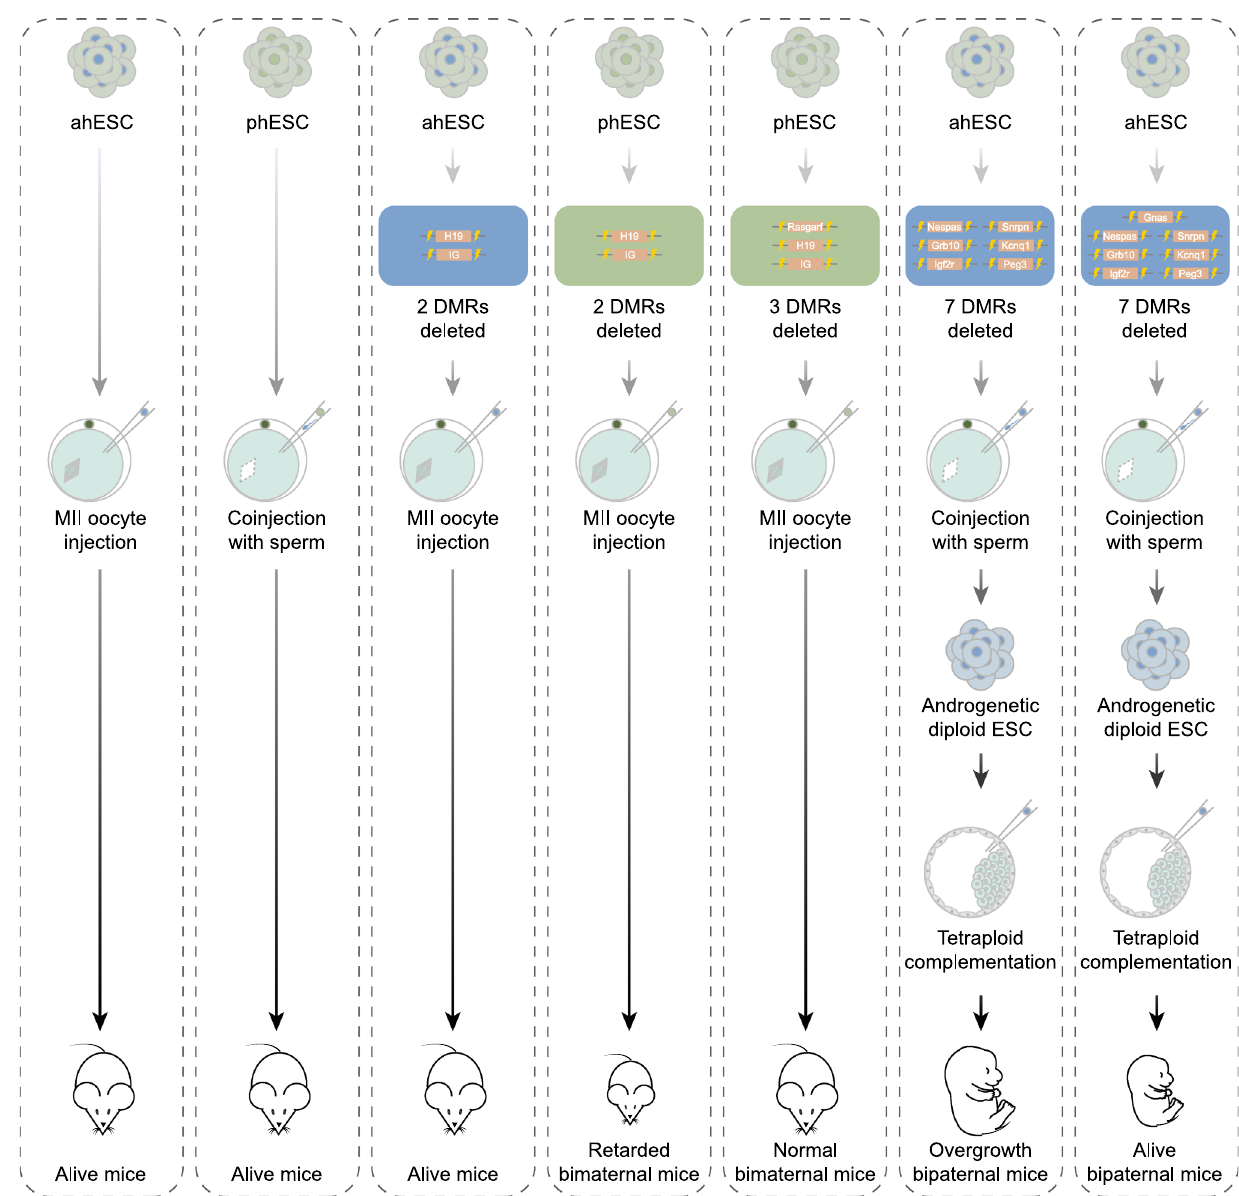
Figure 4. Haploid embryonic stem cells (haESCs) can be used to replace gametes for the generation of alive mice. Deletions of the speci fi c imprinting regions in haESCs can facilitate to generate normally growing bimaternal mice and live bipaternal mice. DMRs, differentially methylated regions. ahESC, androgenetic haESC. phESC, parthenogenetic